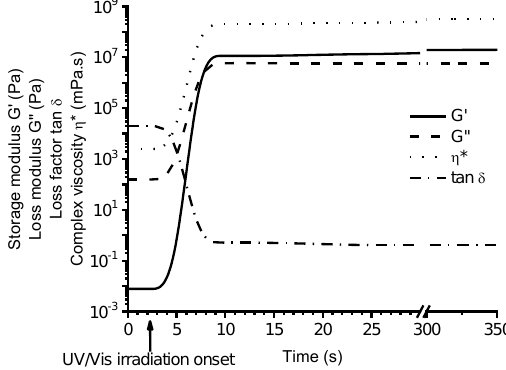
Figure 3. Dependencies of storage modulus G’ , loss modulus G” , loss factor tan δ , and complex viscosity η* of resin C9 on irradiation time, at 24 °C.